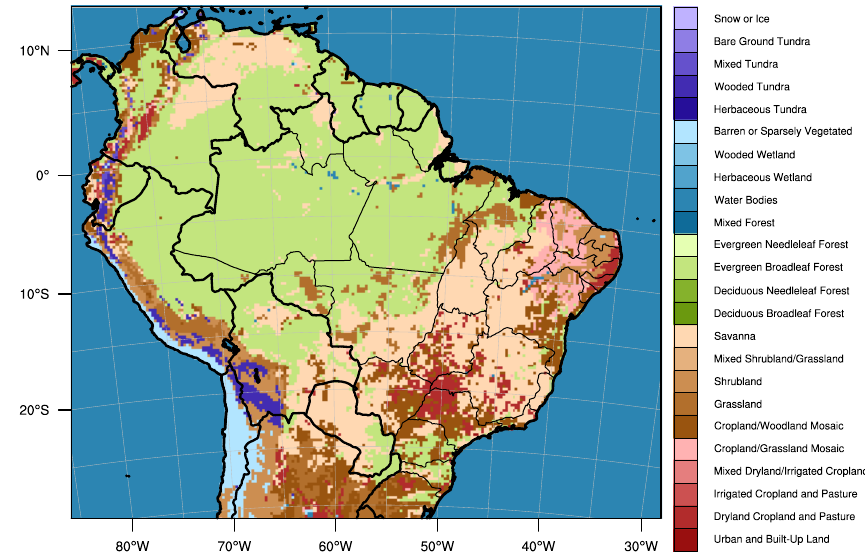
Figure 1. Map of domain used for study, at 25km horizontal grid spacing with lambert projection. Coloured by 24 USGS land use categories. The southern Amazon, coloured green, is the main region of deforestation burning, corresponding to the West-central Brazilian states and northern Bolivia. The East-central Brazilian states, coloured pale-brown, are the main regions of cerrado burning. Table 5. Summary of physical parameterisations used in WRF-Chem model